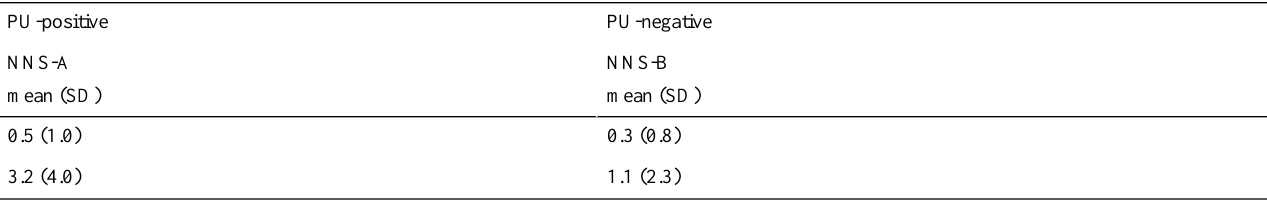
Table 4. Descriptive statistics of patient